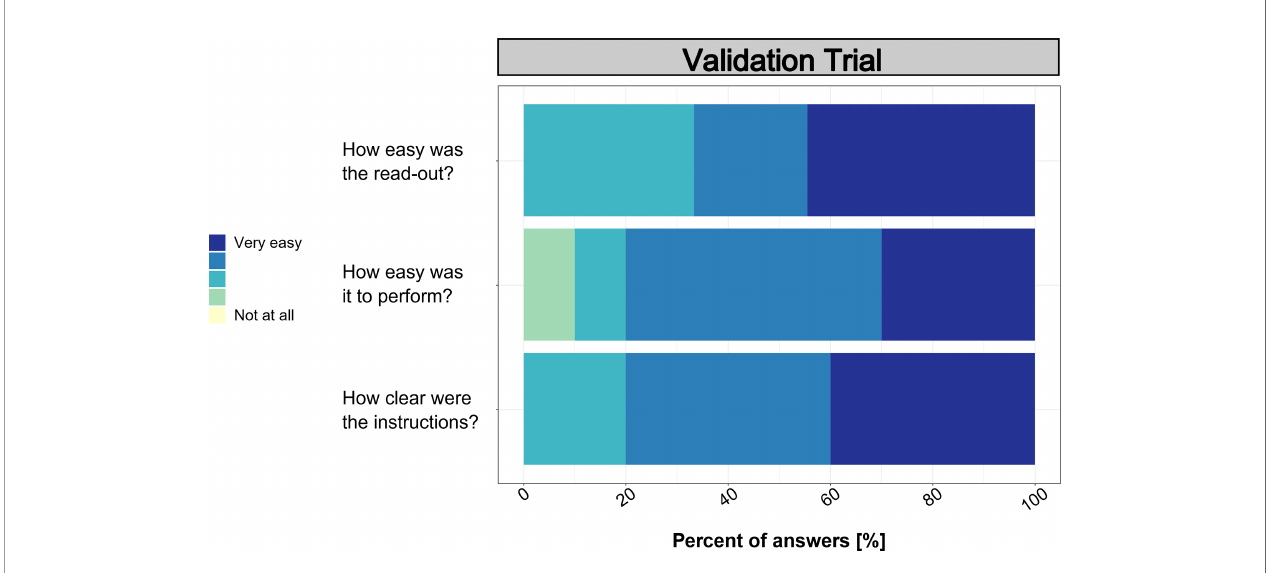
FIGURE 8 | Results from the post-trial surveys on